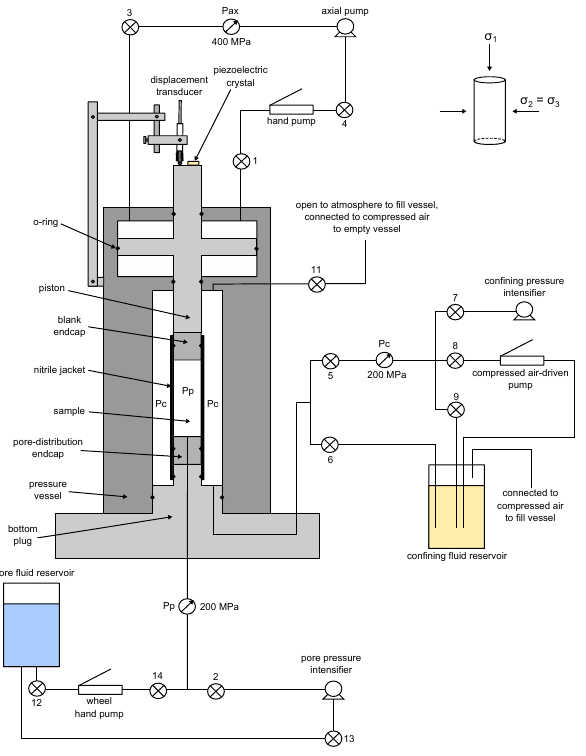
Fig. 4. Schematic diagram of the triaxial deformation apparatus at the Laboratoire de Déformation des Roches, Université de Stras- bourg. Schematic is not to scale.